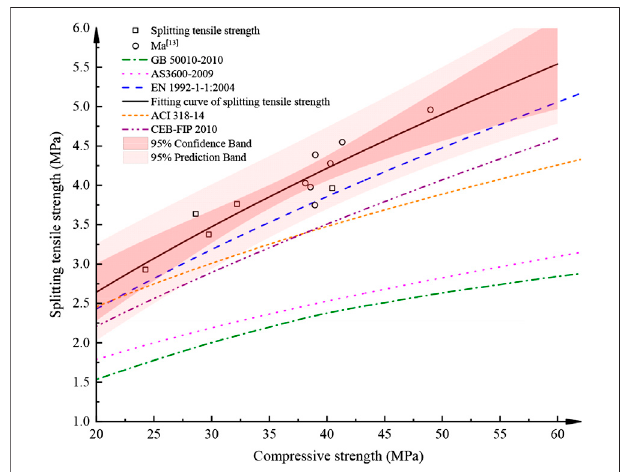
FIGURE 4 | The relationship of cubic compressive strength and splitting tensile strength of SAP